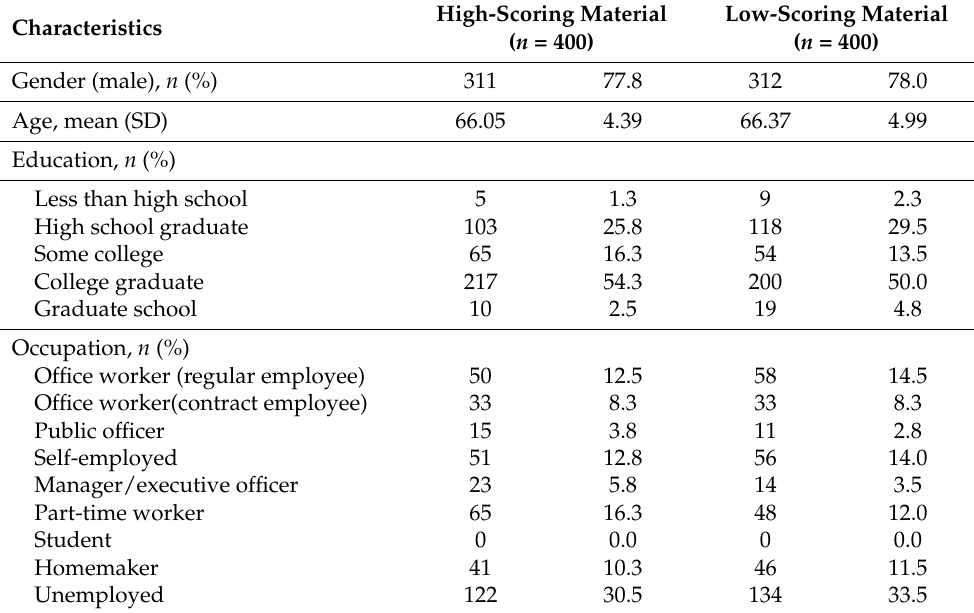
Table 4. Demographic characteristics of participants (PEMAT-A/V).